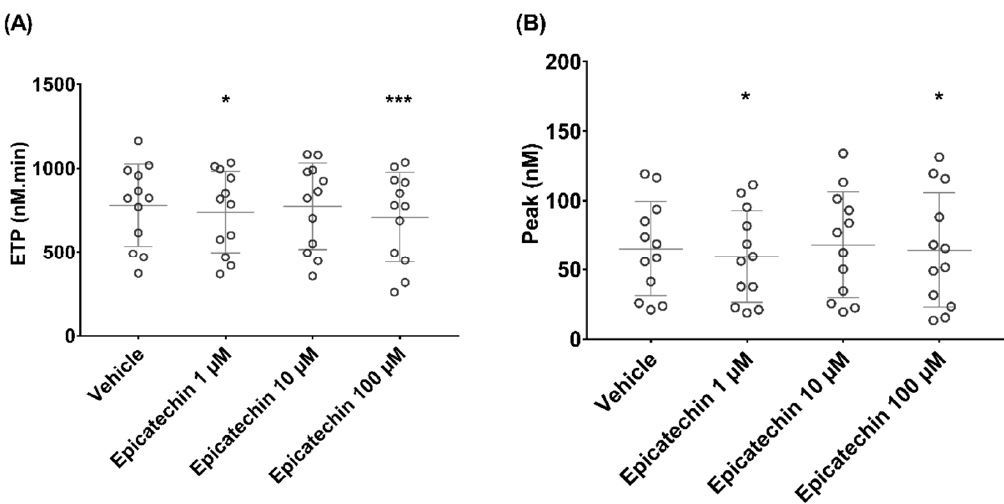
Figure 5. Effect of epicatechin on thrombin generation in microparticle-rich plasma after microparticle release stimulation by incubation with the calcium ionophore. ( A ) Endogenous thrombin potential (ETP). ( B ) Thrombin peak. *, *** Significant effect of intensity.